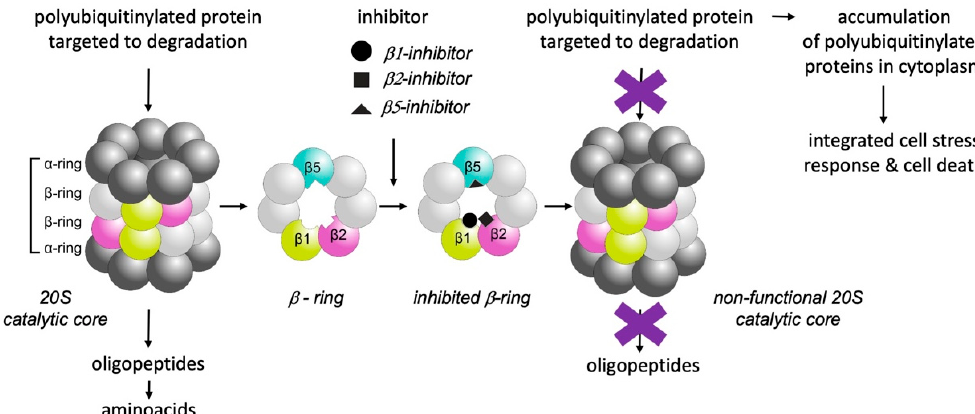
Figure 1. Inhibition of the 20S proteasome catalytic subunits, schematic depiction. The 20S proteasome consists of two outer rings consisting of seven α subunits and two inner rings of seven β subunits. The β 1, β 2 and β 5 subunits are catalytically active and their different substrate specificities are illustrated by the dissimilar shapes of their substrate binding pockets. Proteasome inhibition leads to accumulation of polyubiquitinylated proteins in the cytoplasm and unbalanced protein homeostasis, which causes an integrated stress response and, ultimately, cell death.